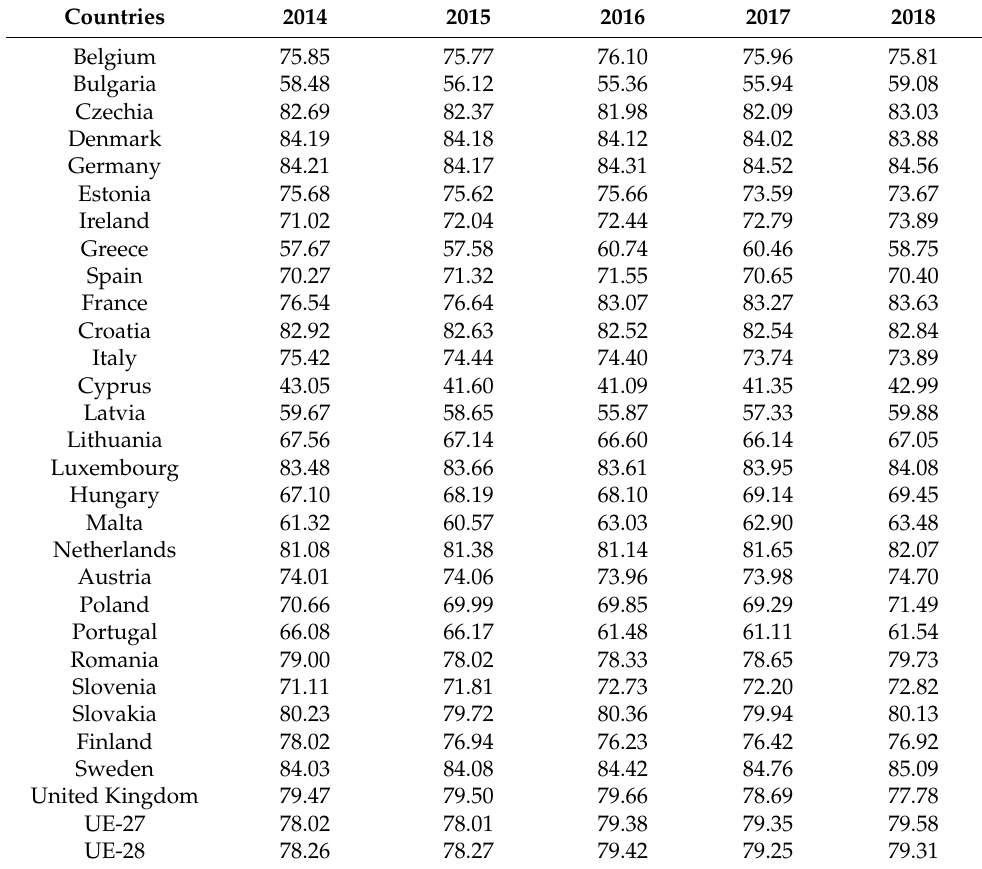
Table 3. Public expenditure on health (PSH) in EU Member States (as % of Total Spending on Health).